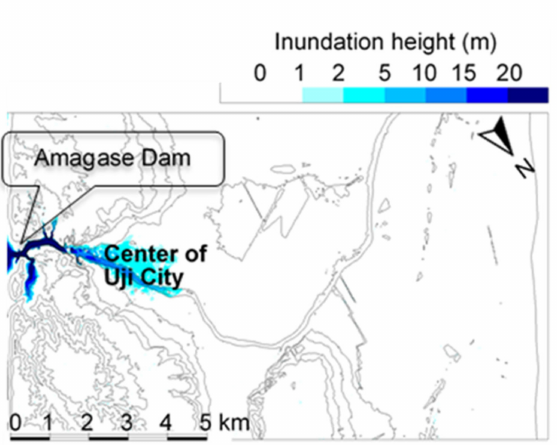
Figure 26. (Case–3). Inundation height, 10 min after start of the calculation.